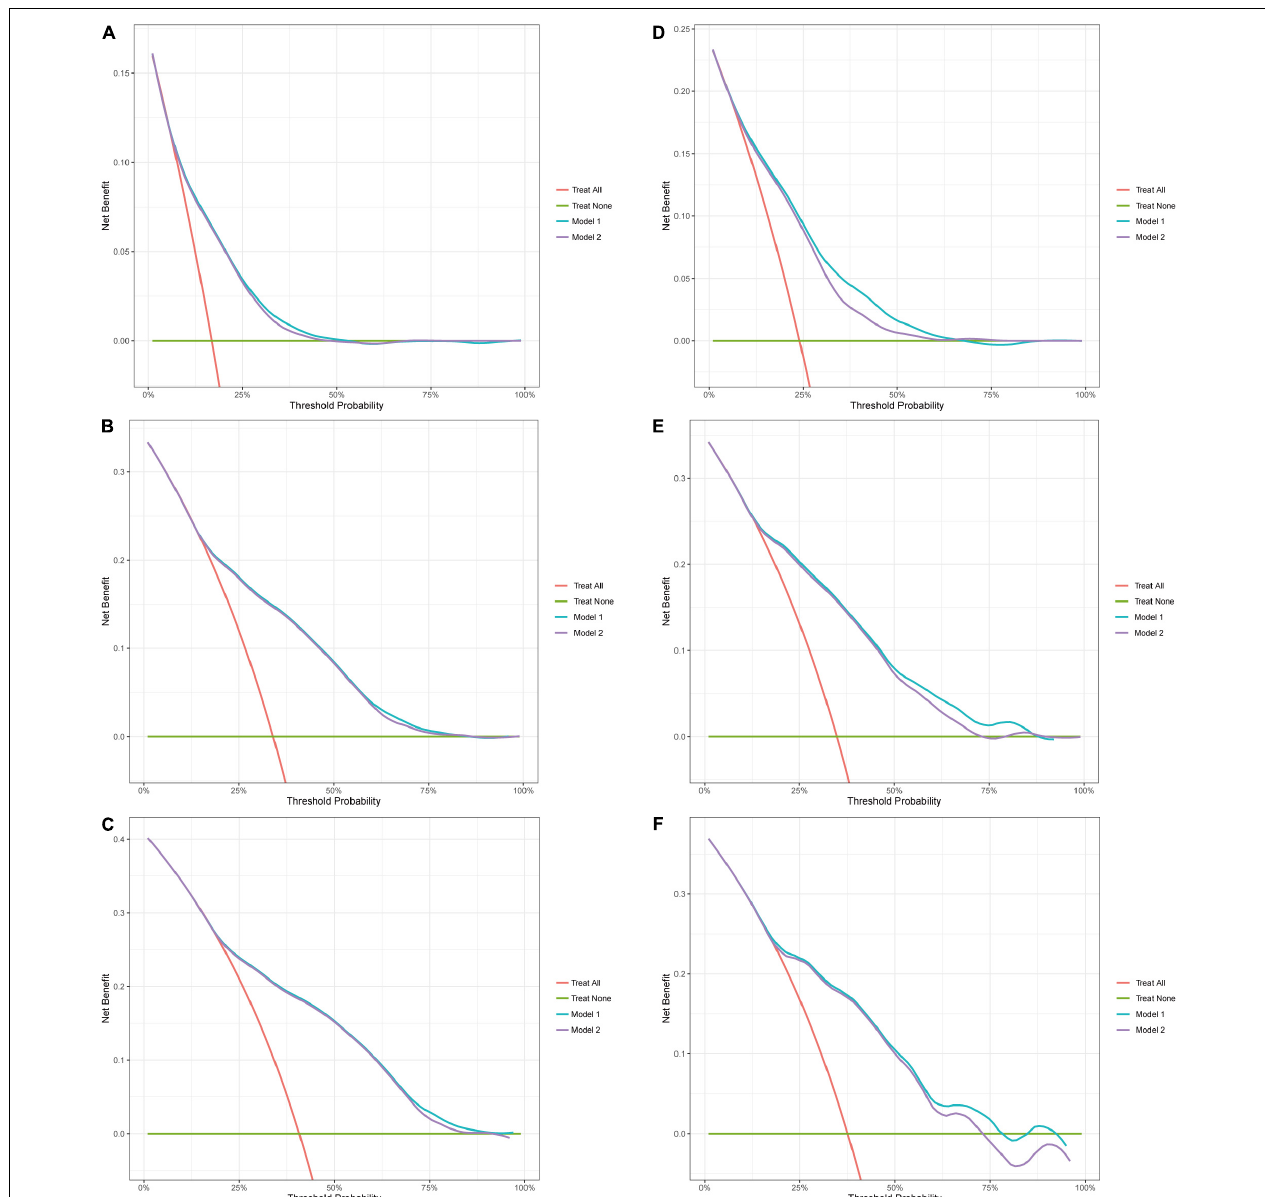
FIGURE 3 | Decision curve analysis (DCA). Decision curve analysis for OS. Red line (Treat all): “all patient dead scheme.” Green line (Treat none): “no patient dead scheme.” Blue line (Model 1): “nomogram model.” Purple line (Model 2): “cancer model.” (A) 1-year DCA in the training cohort; (B) 3-year DCA in the training